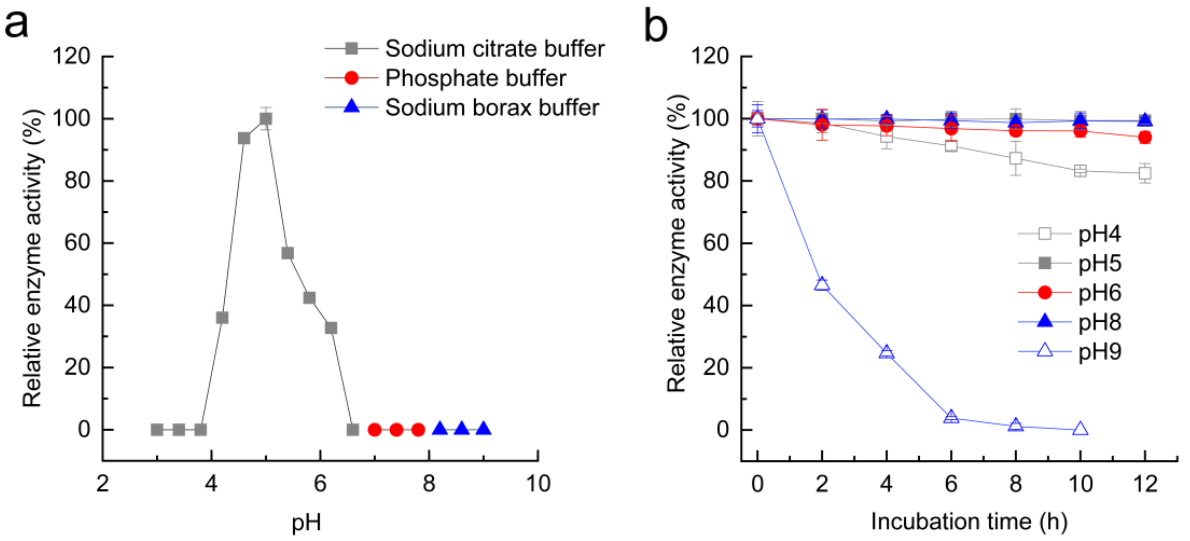
Figure 5. Influences of pH on MpTre15A activity ( a ), and pH stability ( b ). Relative activity under different pH buffer conditions (pH 3.0–6.4, citrate buffer, gray square; pH 7.0–7.8, phosphate buffer, red circle; pH 8.2–9.0, borate buffer, blue triangle) and residual activity after treatment in different pH buffers (pH 4.0 to 9.0) for 12 h were measured. Experiments were performed in triplicate, and the average values are shown.